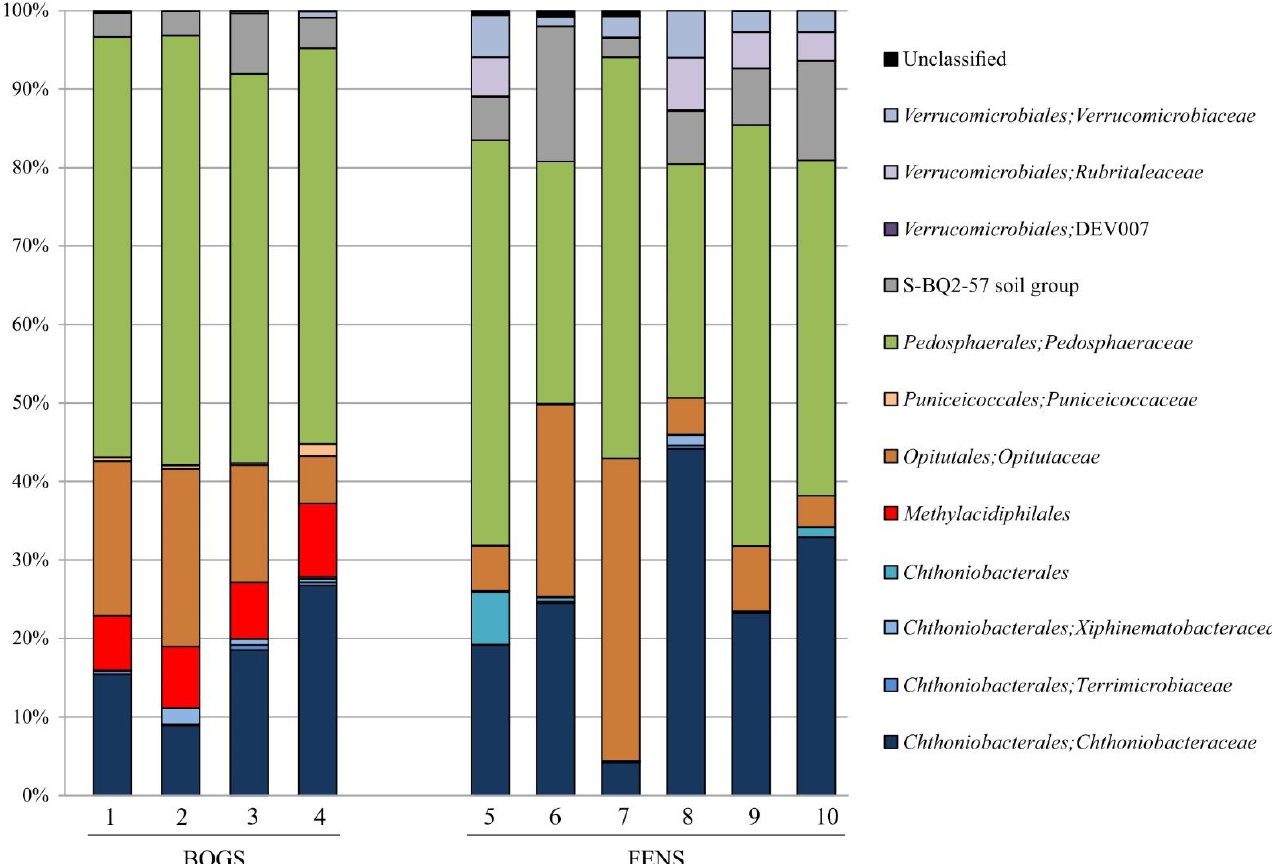
Figure 1. Verrucomicrobia community composition in raised bogs (1-Shichengskoe, 2- Piyavochnoe, 3- Alekseevskoe, 4- Barskoe) and fens (5-Shichengskoe, 6-Piyavochnoe, 7-Rodionskoe, 8-Ileksa, 9-Povreka, 10-Charozerskoe) according to the results of Illumina 16S rRNA gene sequencing. The composition is displayed at the order/family level. The relative abundance values represent averages of three replicate data sets. Taxa with the relative abundance of >0.1% at least for one ecosystem are shown.